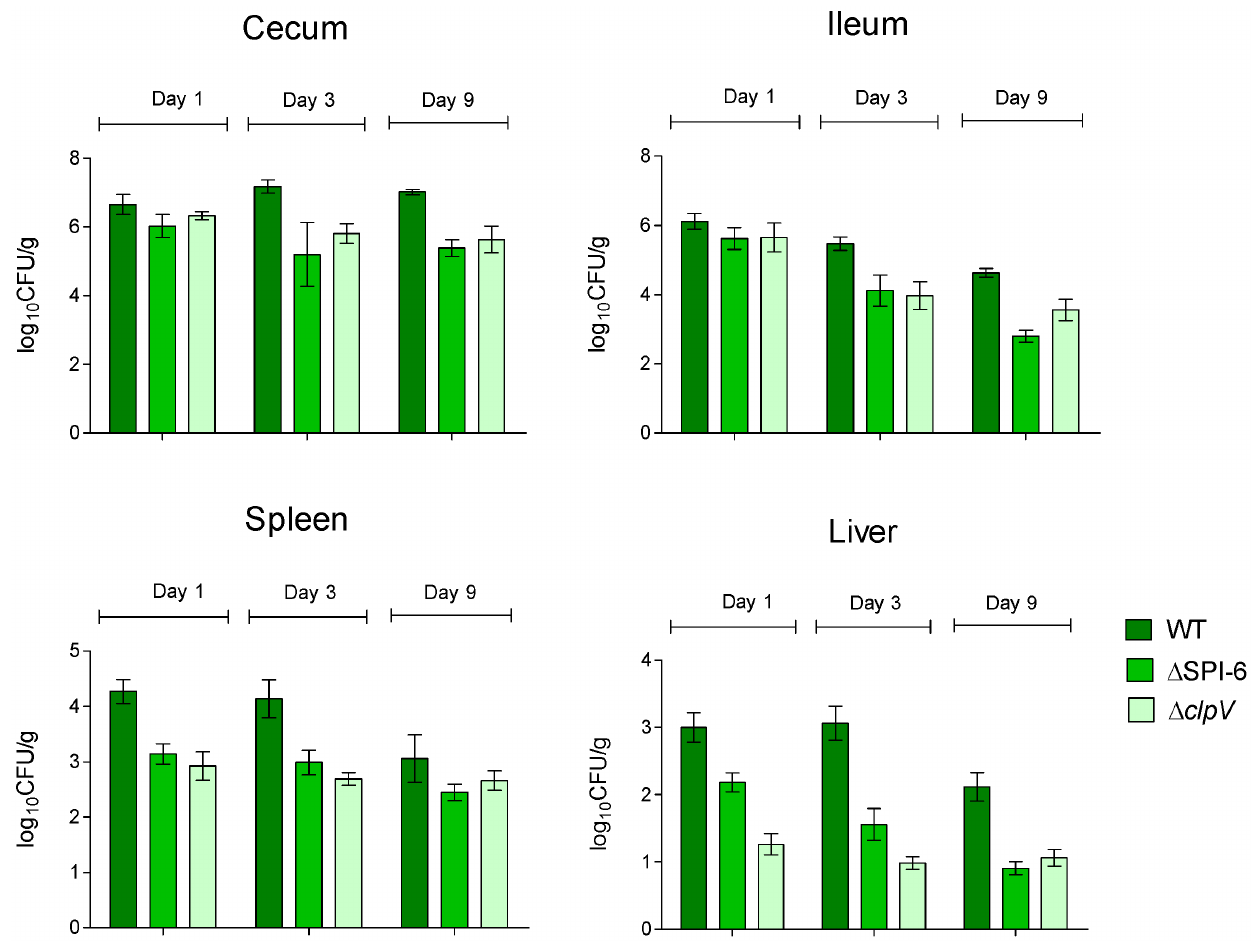
Figure 1. Distribution of S. Typhimurium 14028 s and SPI-6 T6SS mutants in the gastrointestinal tract and internal organs of orally infected chickens. Four-day-old White Leghorn chicks were infected by gavage with 10 9 CFU of either the wild-type S . Typhimurium 14028 s, the D T6SS SPI-6 mutant or the D clpV mutant strains. After 1, 3 and 9 days post-infection, the chicks were humanely euthanized and the ileum, cecum, liver and spleen were aseptically removed. Tissues were homogenized and viable bacterial counts were determined. Data are mean values of log 10 CFU/g of tissue, from five animals at each time point.